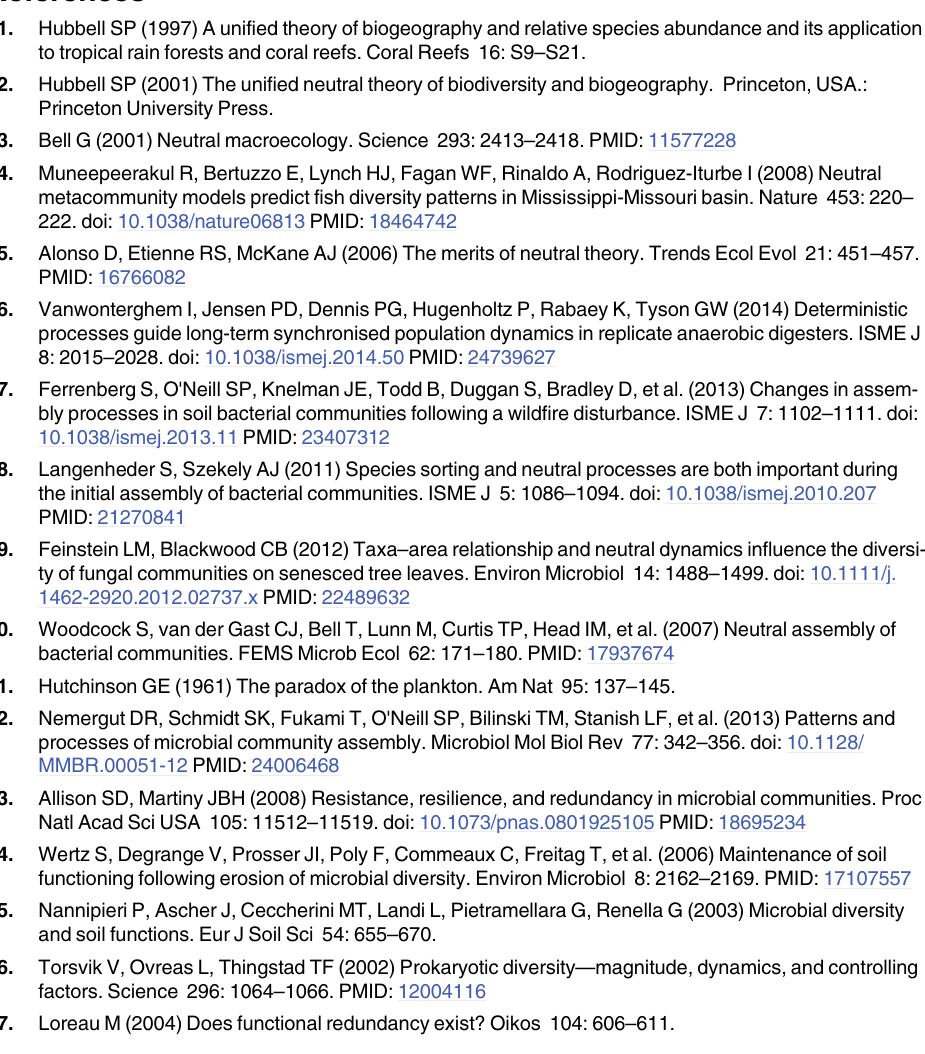
S2 Fig. Nonmetric multidimensional scaling (NMDS) plots based on the between-sample Bray-Curtis dissimilarities. (a), the sandy soil microcosms. (b), the grassland soil microcosms. The analyses were done based on rarefied OTU tables at a depth of 10,000 sequences per sam- ple. The differences in overall community composition between each pair of microcosms were measured by the Bray-Curtis dissimilarity index, based on which nonmetric multidimensional scaling (NMDS) plots were derived. These analyses were carried out using the vegan package in the R environment.